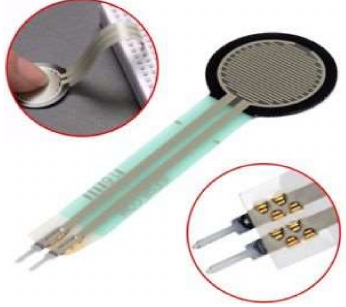
Figure 8. Tactile Sensor of 0.5 inch in size